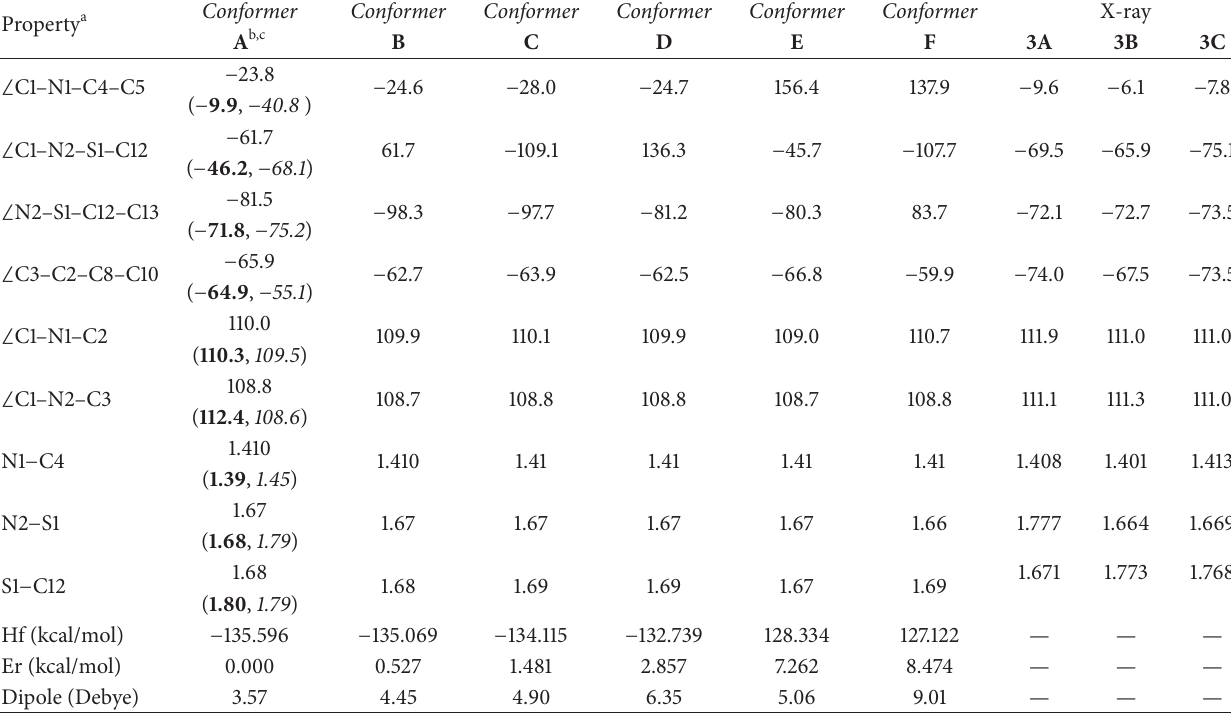
Table 5: Heat of formations, relative energies, dipole moments, and selected geometric parameters for the significant conformations of 3 computed using semiempirical AM1 MO level of theory. Comparative analysis with crystal structure 3 a .